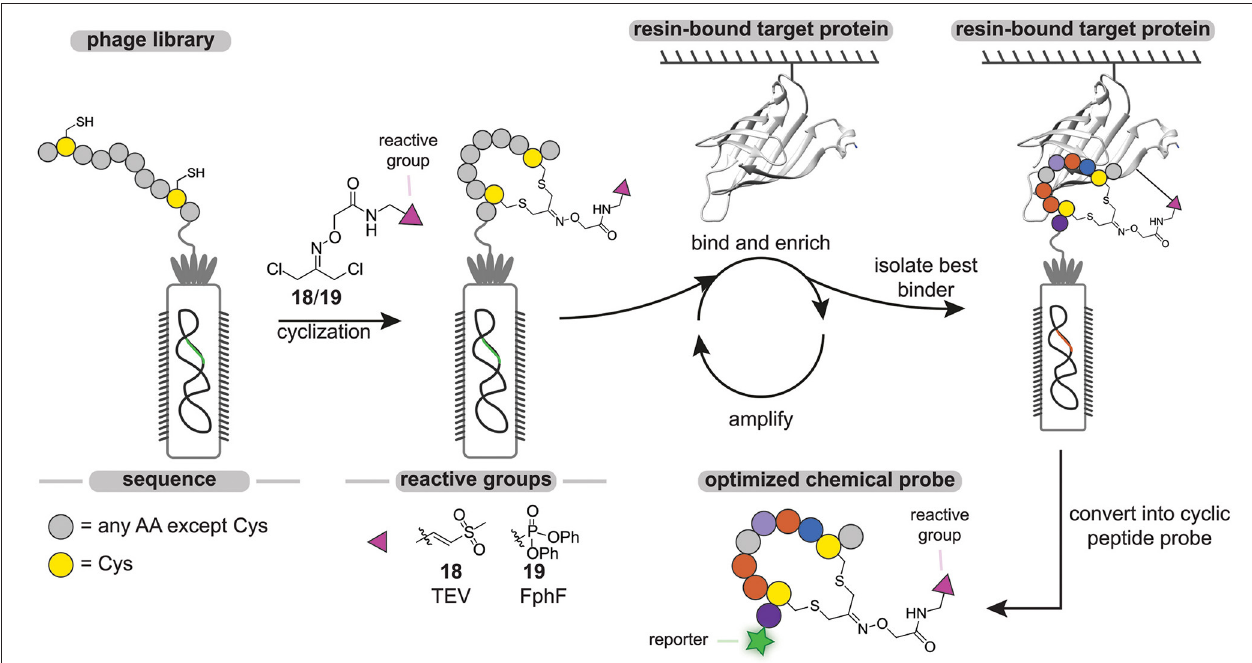
FIGURE 7 | Schematic representation of the phage-display cyclic peptide probe synthesis and screening approach. Different peptides containing two cysteine residues on fixed positions are expressed on the PIII protein of phages. The phage peptide library is cyclized with a dichloroacetone-functionalized vinylsulfone ( 18 ) or fluorophosphonate ( 19 ) reactive group. The library is incubated with the immobilized target protein. After the labeling step, all the unbound phage is washed away. The bound phage is liberated by denaturing or by cleavage with a protease. The enriched phage is amplified in E. coli cells. After three cycles, the consensus sequence is determined by